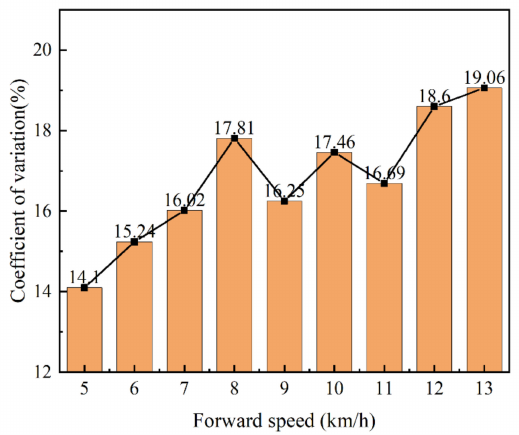
Figure 13. Standard deviation (percent of pass).